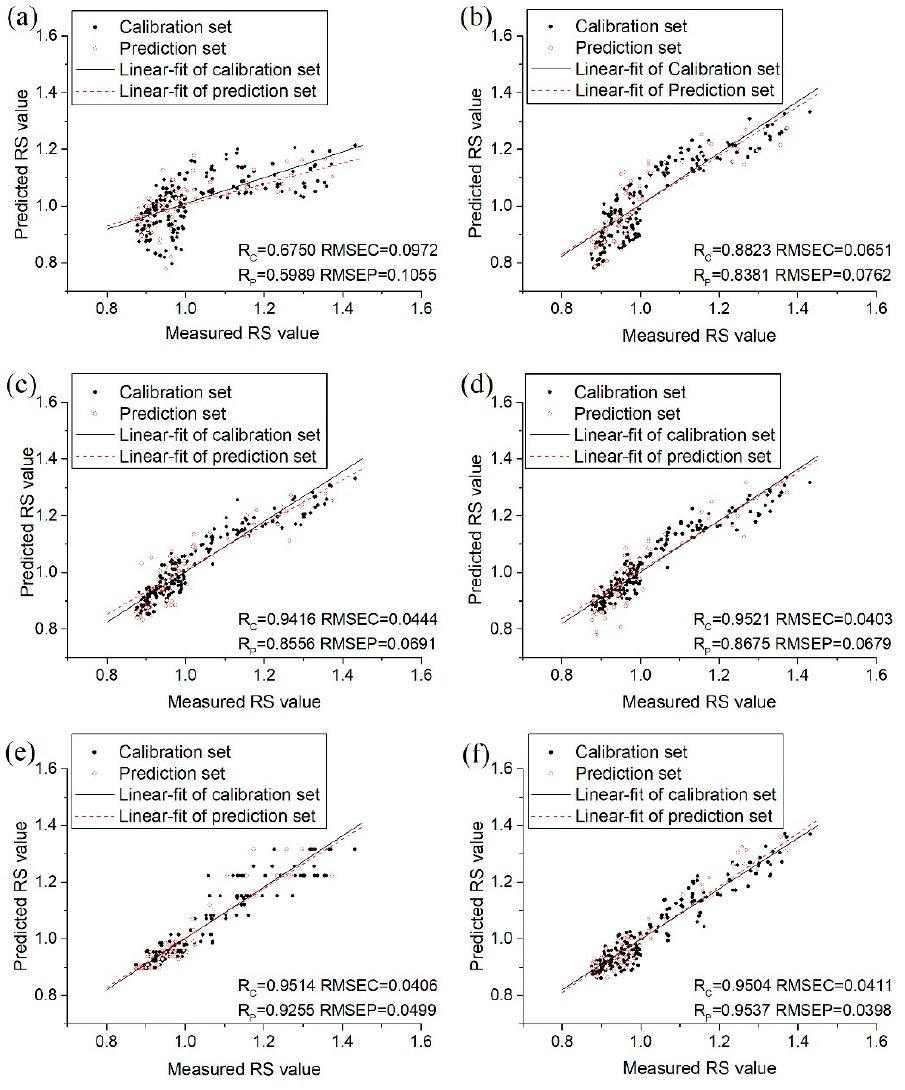
Figure 5. Scatter plot of measured value and predicted value of RS: ( a ) polynomial regression; ( b ) SVR; ( c ) RBFNN; ( d ) ELM; ( e ) DT; ( f ) MLP.